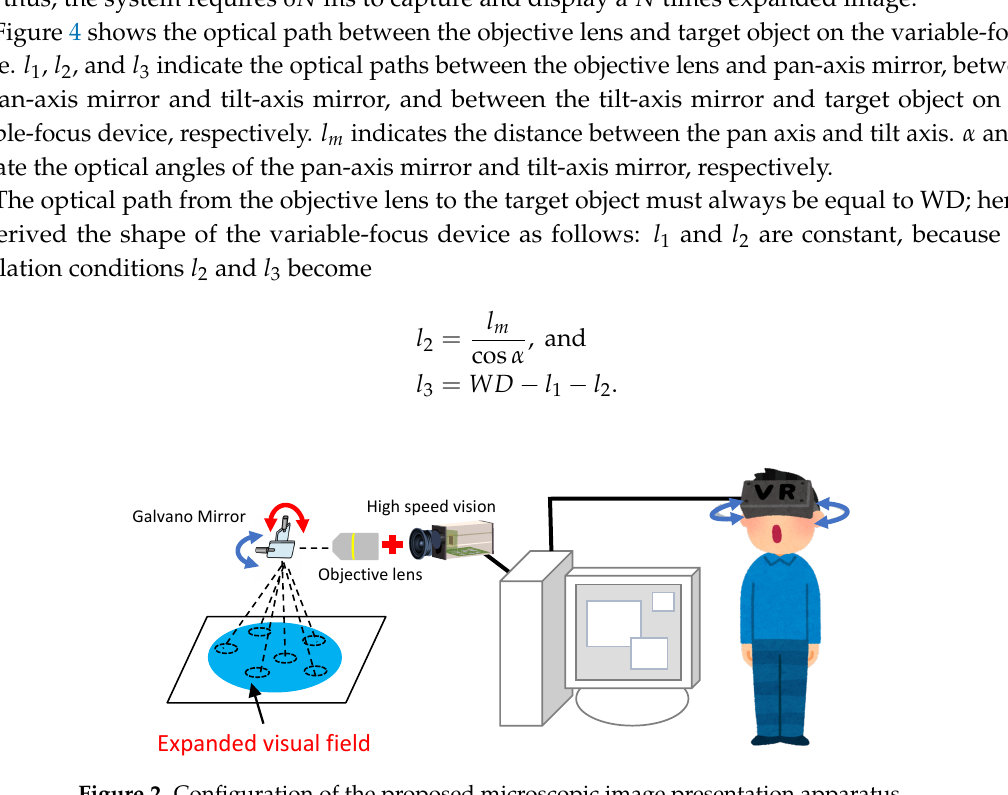
Figure 2. Configuration of the proposed microscopic image presentation